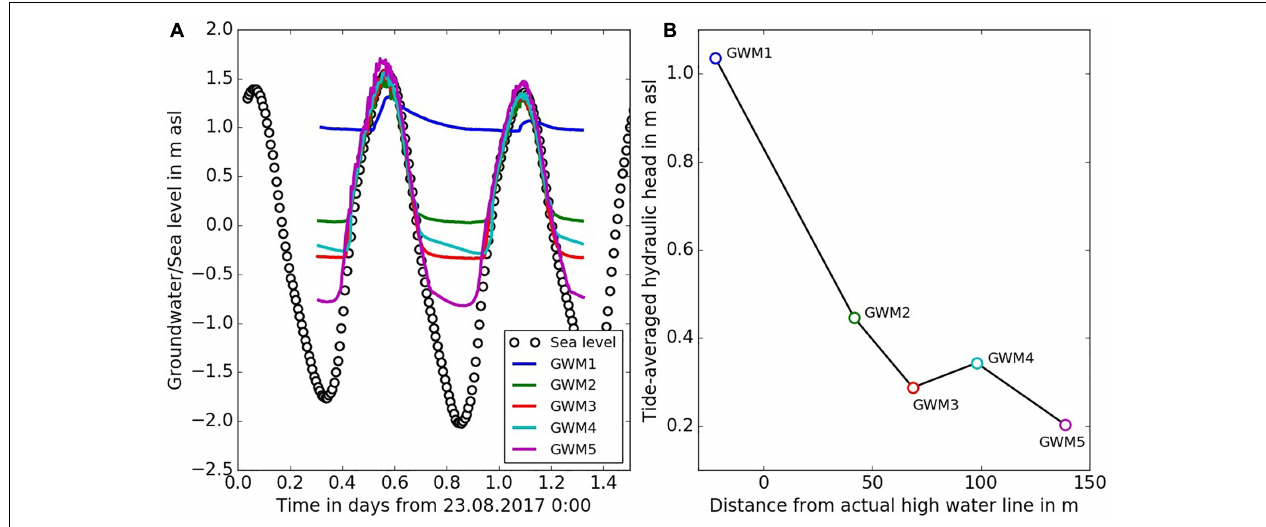
FIGURE 3 | Hydraulic head data measured during the August 2017 campaign, (A) measured time series of hydraulic heads at monitoring wells GWM1 – GWM5 and the actual sea water level, (B) corresponding tide-averaged hydraulic heads at monitoring wells GWM1 – GWM5 along the cross-shore profile indicated in Figure 2 .